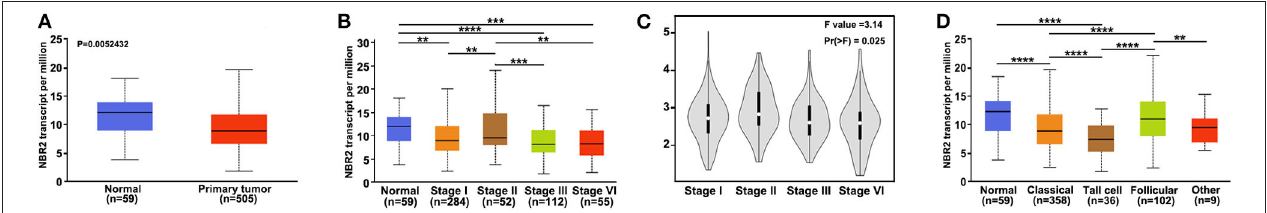
FIGURE 1 | LncRNA NBR2 expression is down-regulated in TC tissues. (A) Relative levels of NBR2 transcripts in 505 TC and 59 non-tumor thyroid tissues in TCGA. (B) (UALCAN), (C) (GEPIA). Stratification analysis of NBR2 expression in the different stages of TC. (D) The levels of NBR2 expression in the different histologic